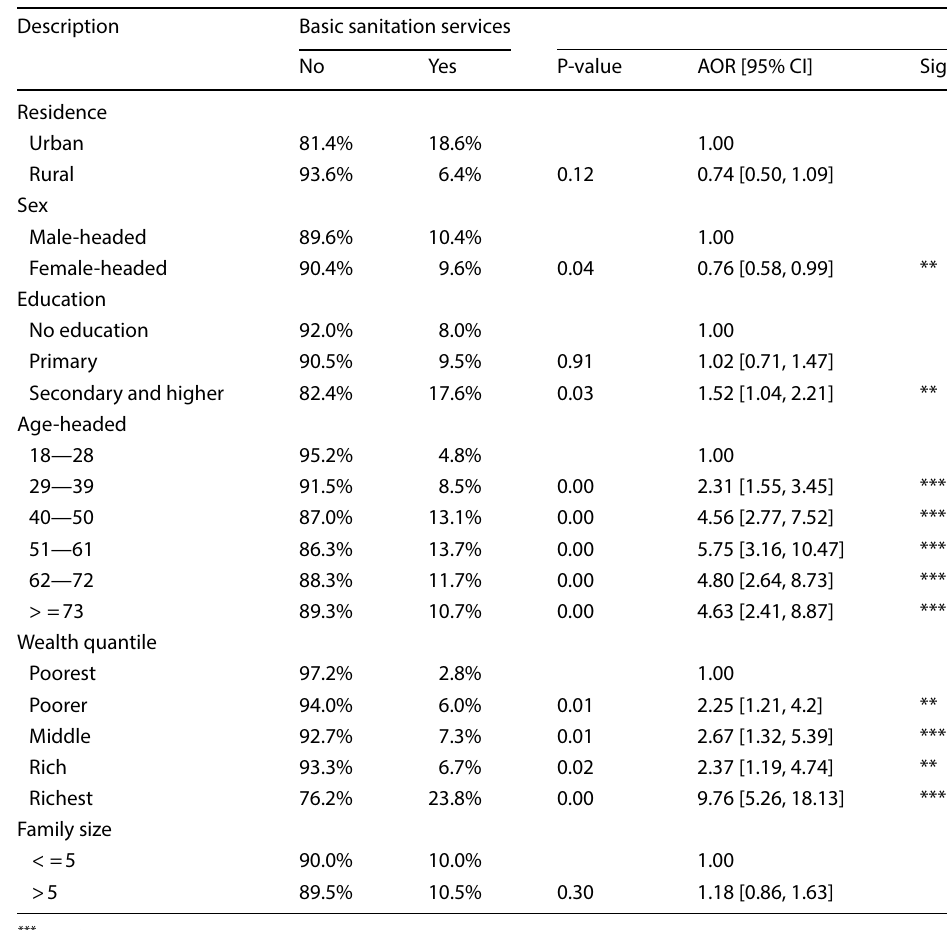
Table 3 Multivariate logistic regression analysis for basic sanitation service ladder with selected explanatory variables among respondents (Source: 2019 EDHS